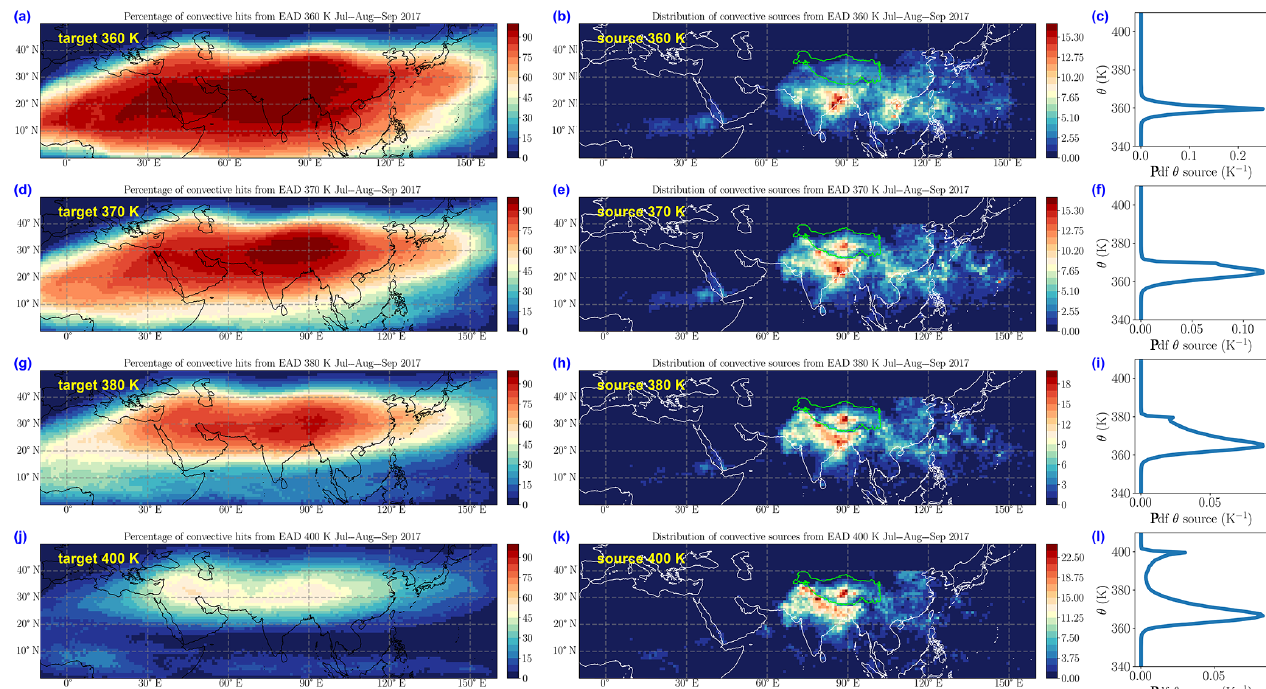
Figure 9. Left column (a, d, g, j) : percentage of parcels hitting a convective cloud within 44d for ERA5 diabatic backward trajectories starting at 380K (a) , 390K (b) , 400K (g) and 420K (j) over the interval 1 July–30 September 2017. Centre column (b, e, h, k) : equalized source density for the same levels as in the left column and the same experiment. Right column (c, f, i, l) : vertical probability density function (in K − 1 ) of the cumulated source density for the same levels as the two left